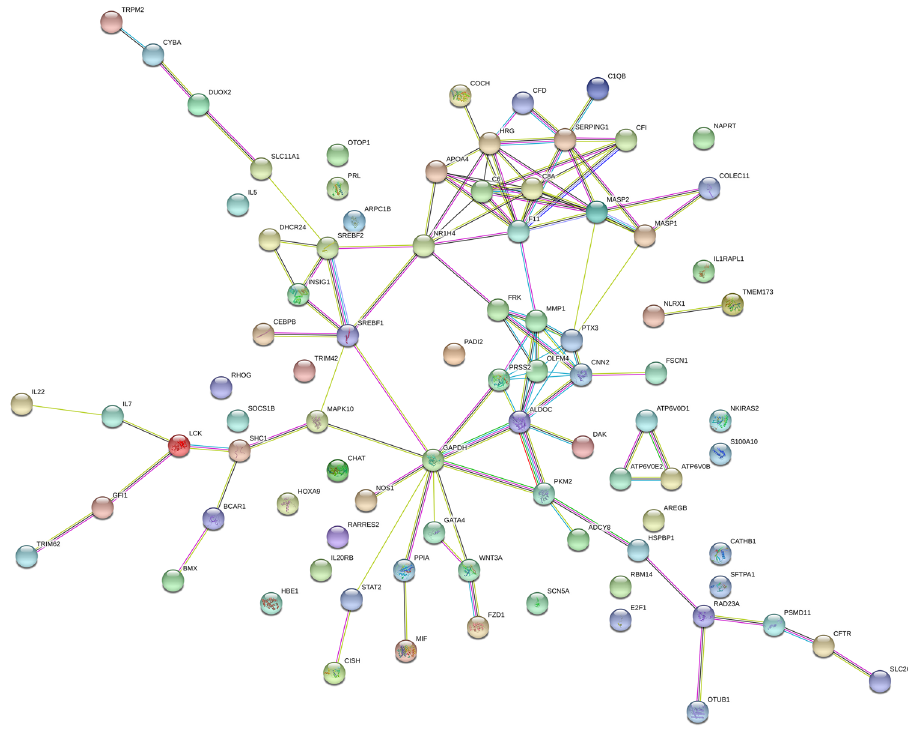
Figure 5. Potential interaction networks of proteins encoded by innate immune genes. The interaction networks were drawn using the STRING: functional protein association networks (https:// string- db.